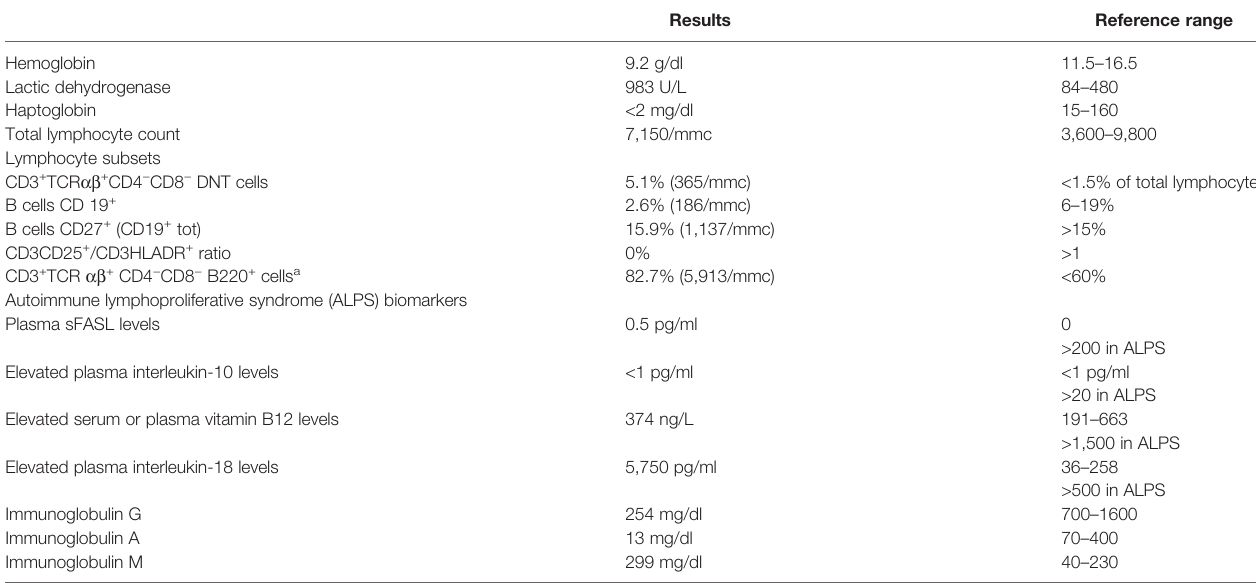
TABLE 1 | Signi fi cant laboratory tests at admission in our